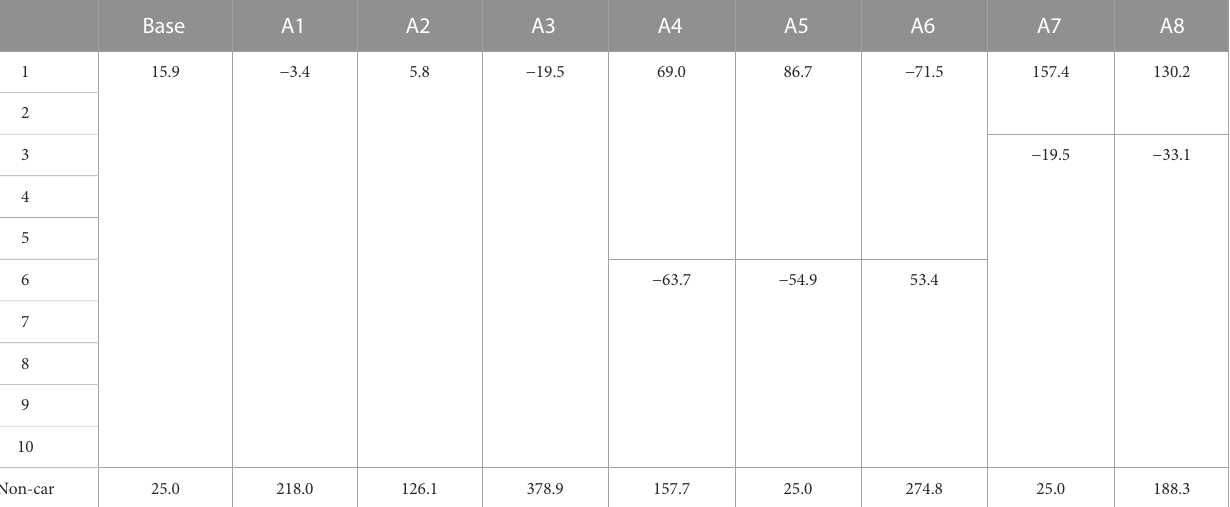
TABLE 4 Final budgets under different allocation